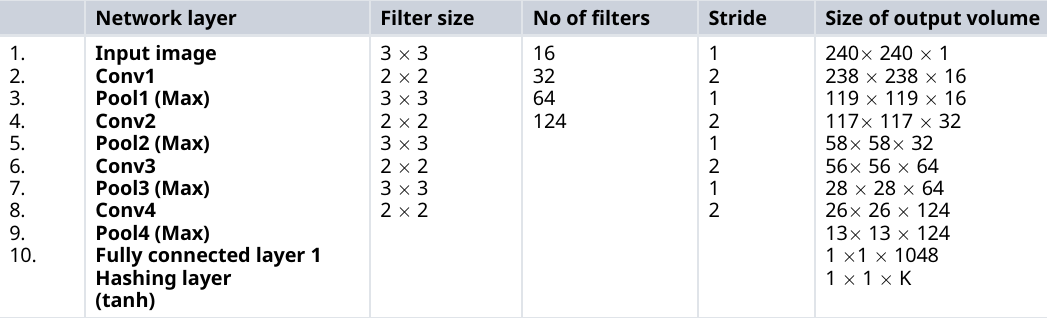
Table 1. The convolutional neural network (CNN) architecture for the proposed model.